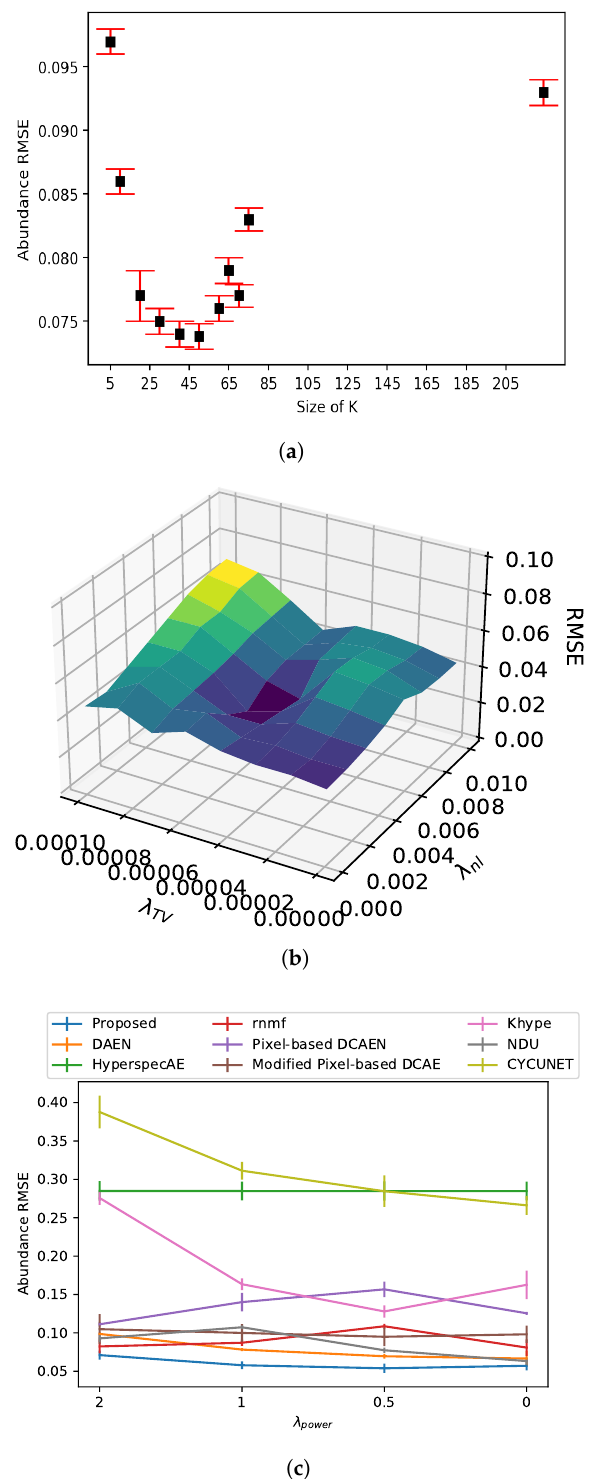
Figure 5. Model performance as function of regularization parameters and kernel size. ( a ) Abundance RMSE vs. kernel size K of the proposed model. ( b ) Abundance RMSE vs. regularization parameters λ nl and λ TV . ( c ) Abundance RMSE vs. regularization parameter λ power